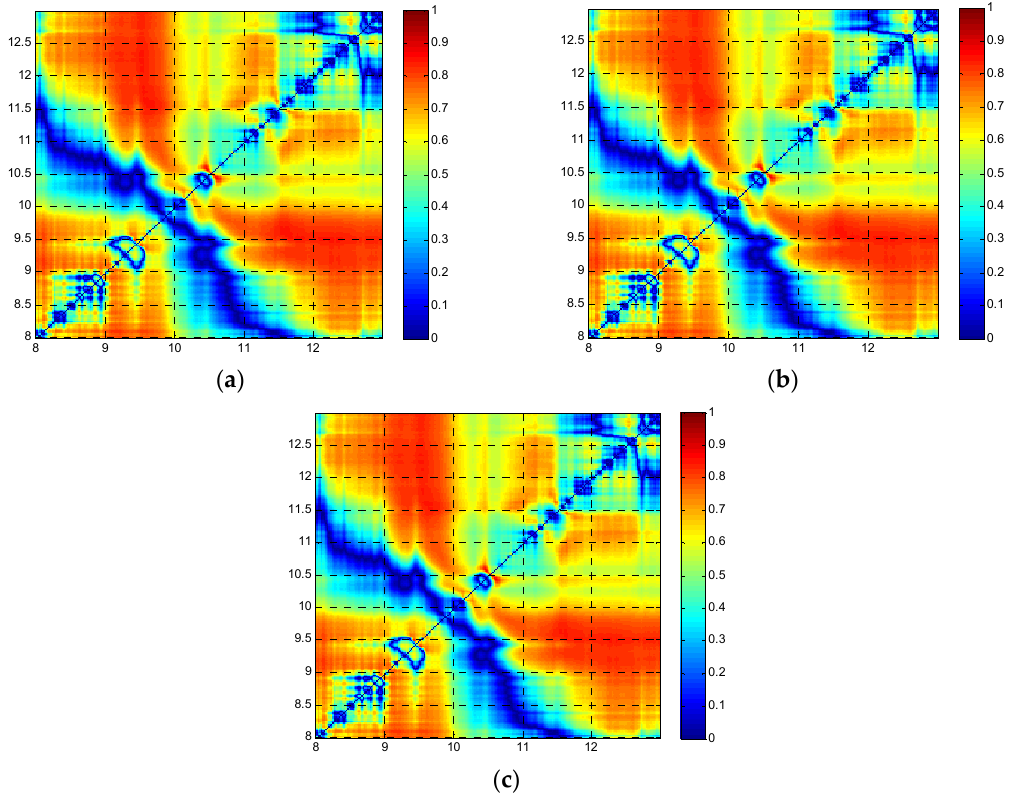
Figure 5. ( a ) Correlation map of difference index (DI) and fixed carbon content; ( b ) correlation map of ratio index (RI) and fixed carbon content; and ( c ) correlation map of normalized difference index (NDI) and fixed carbon content.